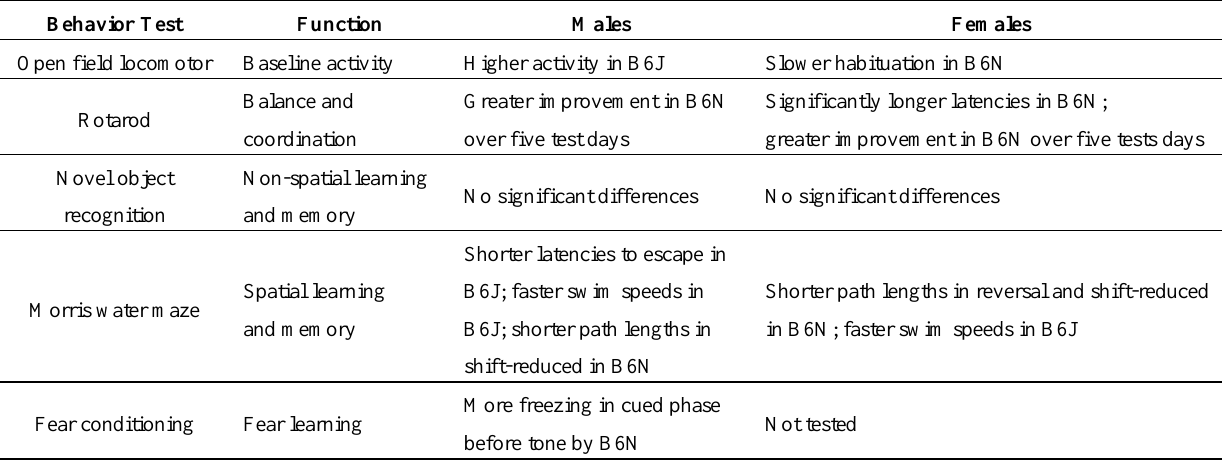
Table 2. Summary of significant